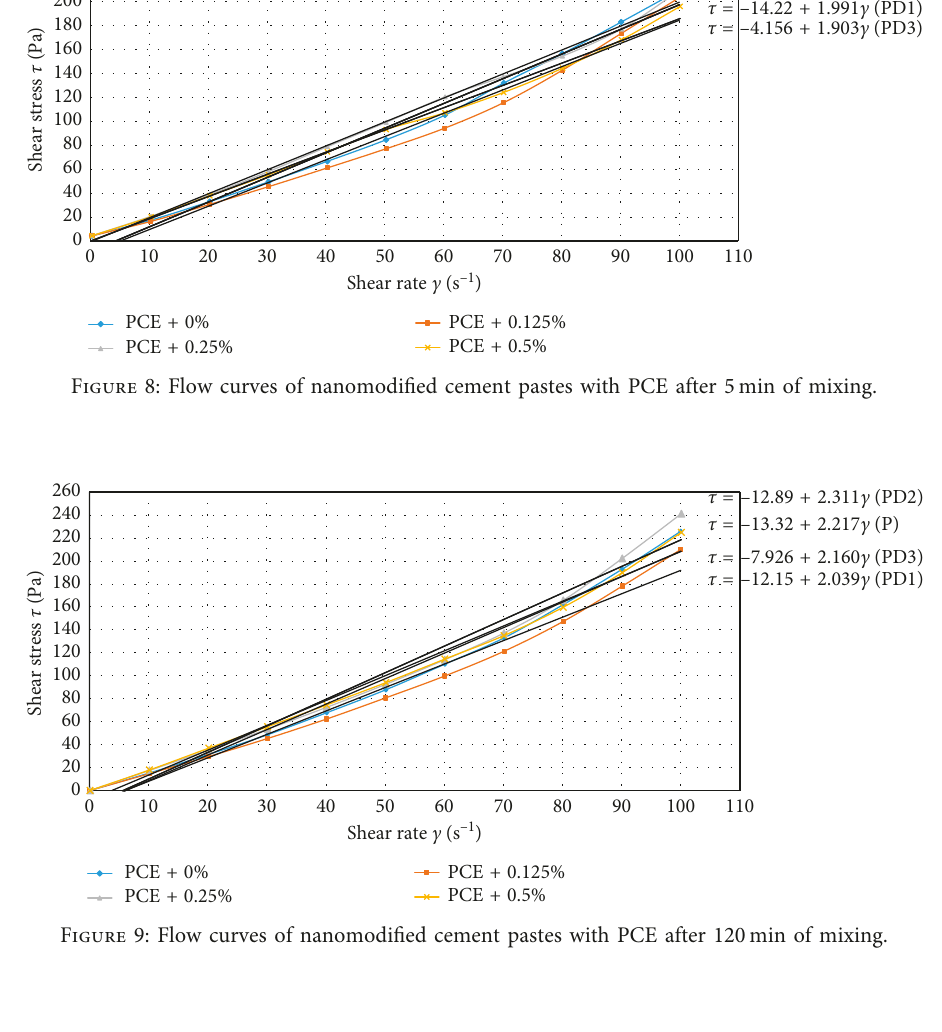
Table 6: Values of plastic viscosity and yield stress for nanomodified cement pastes with PCE. Dosage of PCE +MWCNT dispersion